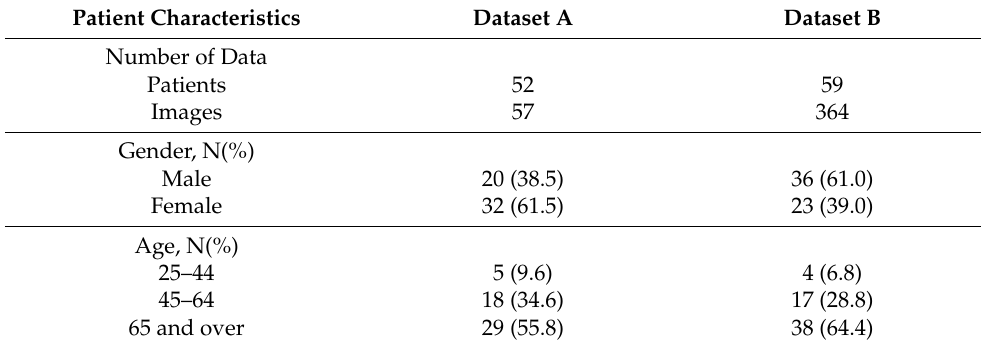
Table 1. Dataset description.